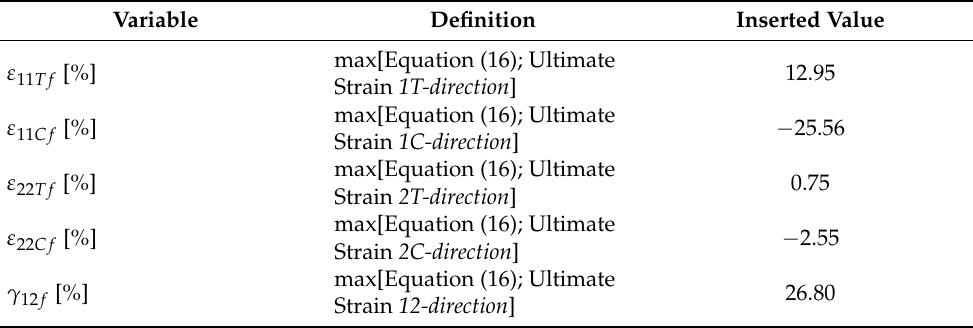
Table 14. Material-aligned erosion deformation for the selected material and FE mesh characteristics.